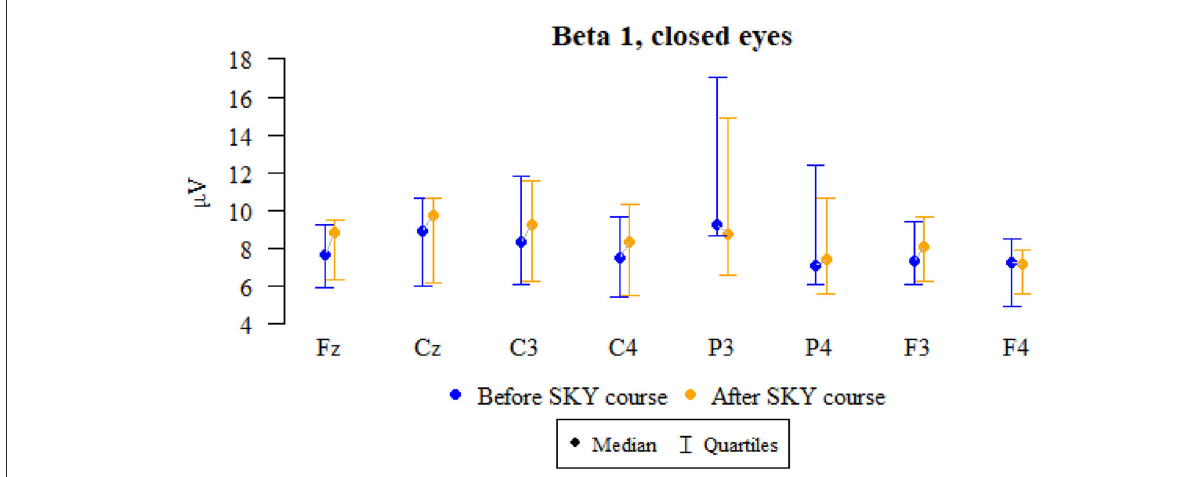
FIGURE4 Graphical comparison of Beta 1 wave amplitudes before the SKY course (first day) and after the whole SKY course (third day) with eyes closed.